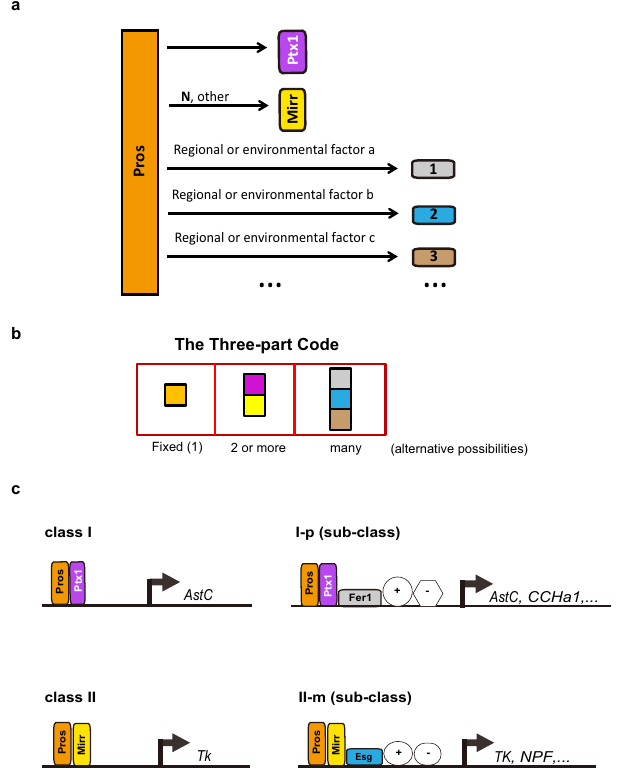
Fig. 7 | Thehierarchicalmodeland thethree-part codeprincipleunderlying EE subtypediversity.a Prosisaselectorproteininde fi ningEEidentity,asitservesat thetopofthehierarchyandgloballyregulatesthetranscriptionofboththesecond level (2 0 ) TFs [including but not limited to Ptx1 and Mirr (whose expression also requires Notch activity)], and the third level (3 0 ) TFs, the expression of many of which also requires local or regional factors. b The combination principles of the three-part TF code and the theoretical combination possibilities underlying EE diversity. There is only one 1 0 TF (Pros); the 2 0 TFs include Ptx1 and Mirr, and potentially additional ones, such as the ones for class III EE identity; and there are multiple (>12) 3 0 TFs. c The TF code model in determining class EE subtypes and sub-class EE subtypes. The combination of Pros and one of the 2 0 TFs determines the identity of the major subtypes (such as class I and II); and the combination of Pros,2 0 TF,and3 0 TFsfurtherre fi nesenhanceractivityanddeterminessubclassEE subtypes and hormone expression pro fi les. Conceivably, further addition of co- activators or co-repressors may allow additional diversity of EE subtypes, and/or generationofdynamichormoneexpressionpatternsforeachspeci fi